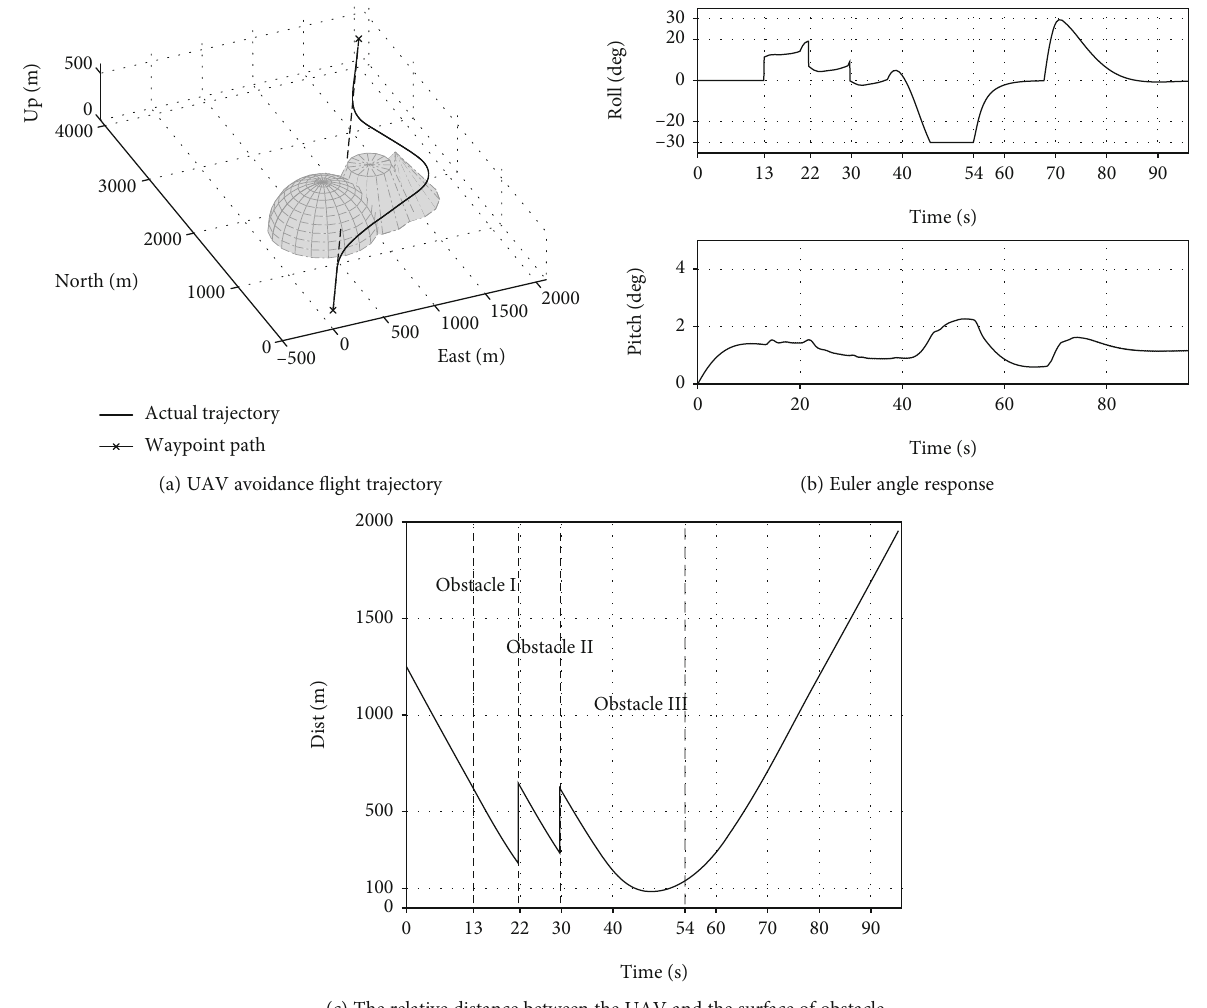
Figure 11: UAV fl ight status of complex obstacle avoidance